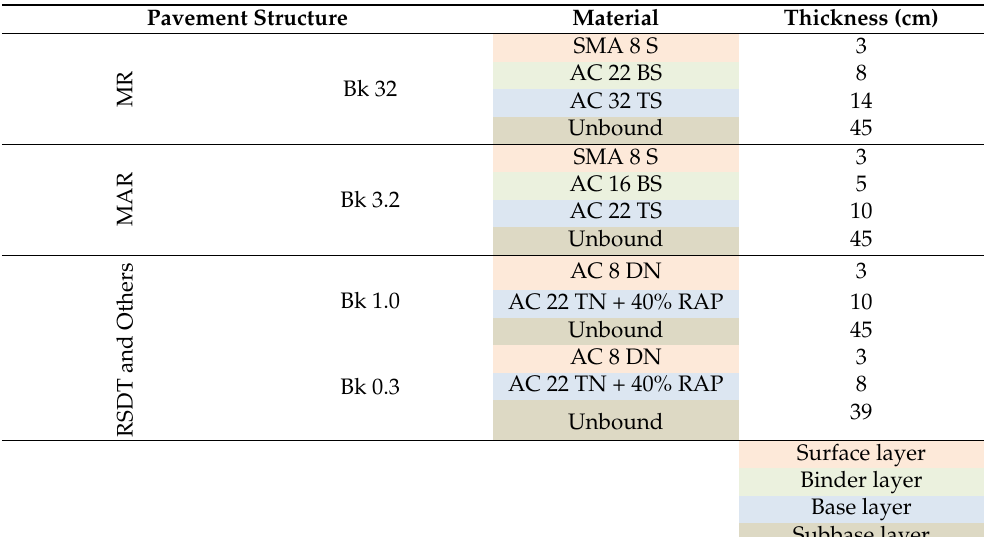
Figure 1. Nomenclature of asphalt materials [23]. Table 1. Pavement specifications. Colors show the pavement layer where the material is applied.